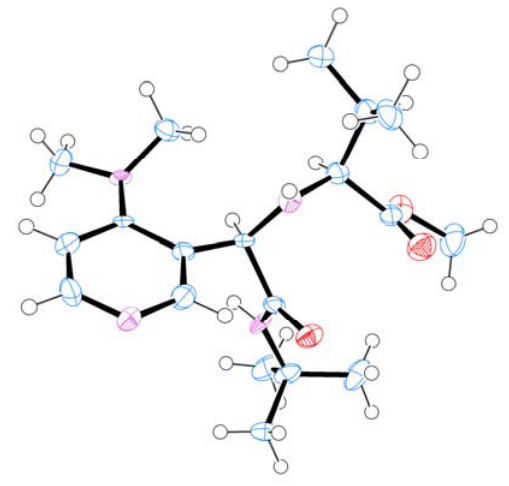
Figure 1. X-ray structure of major diastereomer of 4a ; disordered atoms omitted for